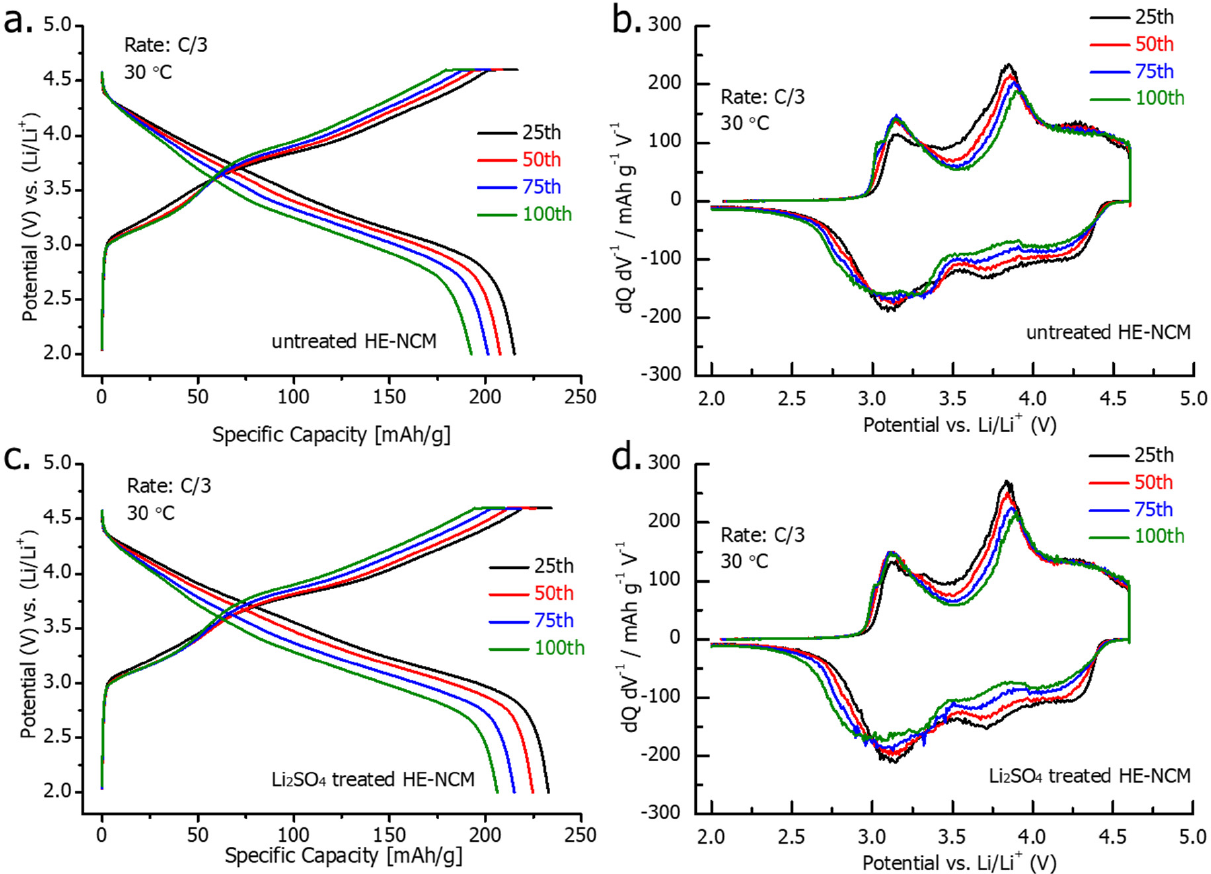
Figure 8. Voltage profiles and dQ/dV vs. V plots, recorded at a C/3 rate from 25th, 50th, 75th, and 100th cycles for untreated ( a , b ) and Li 2 SO 4 treated ( c , d ) HE-NCM cathodes in Li cells at 30 °C.